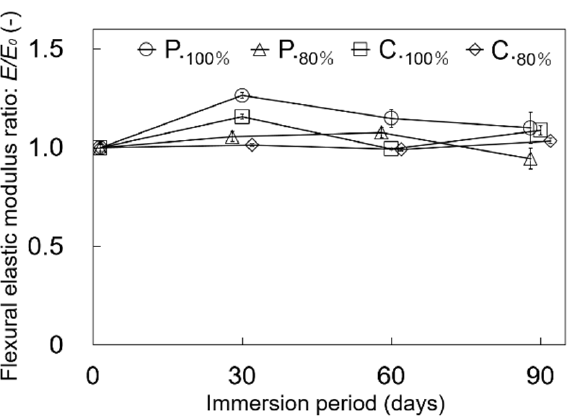
Figure 13. Comparison of the changes of the flexural elastic moduli of the four test piece types brought about by the immersion. Average ± S.D., N = 5.